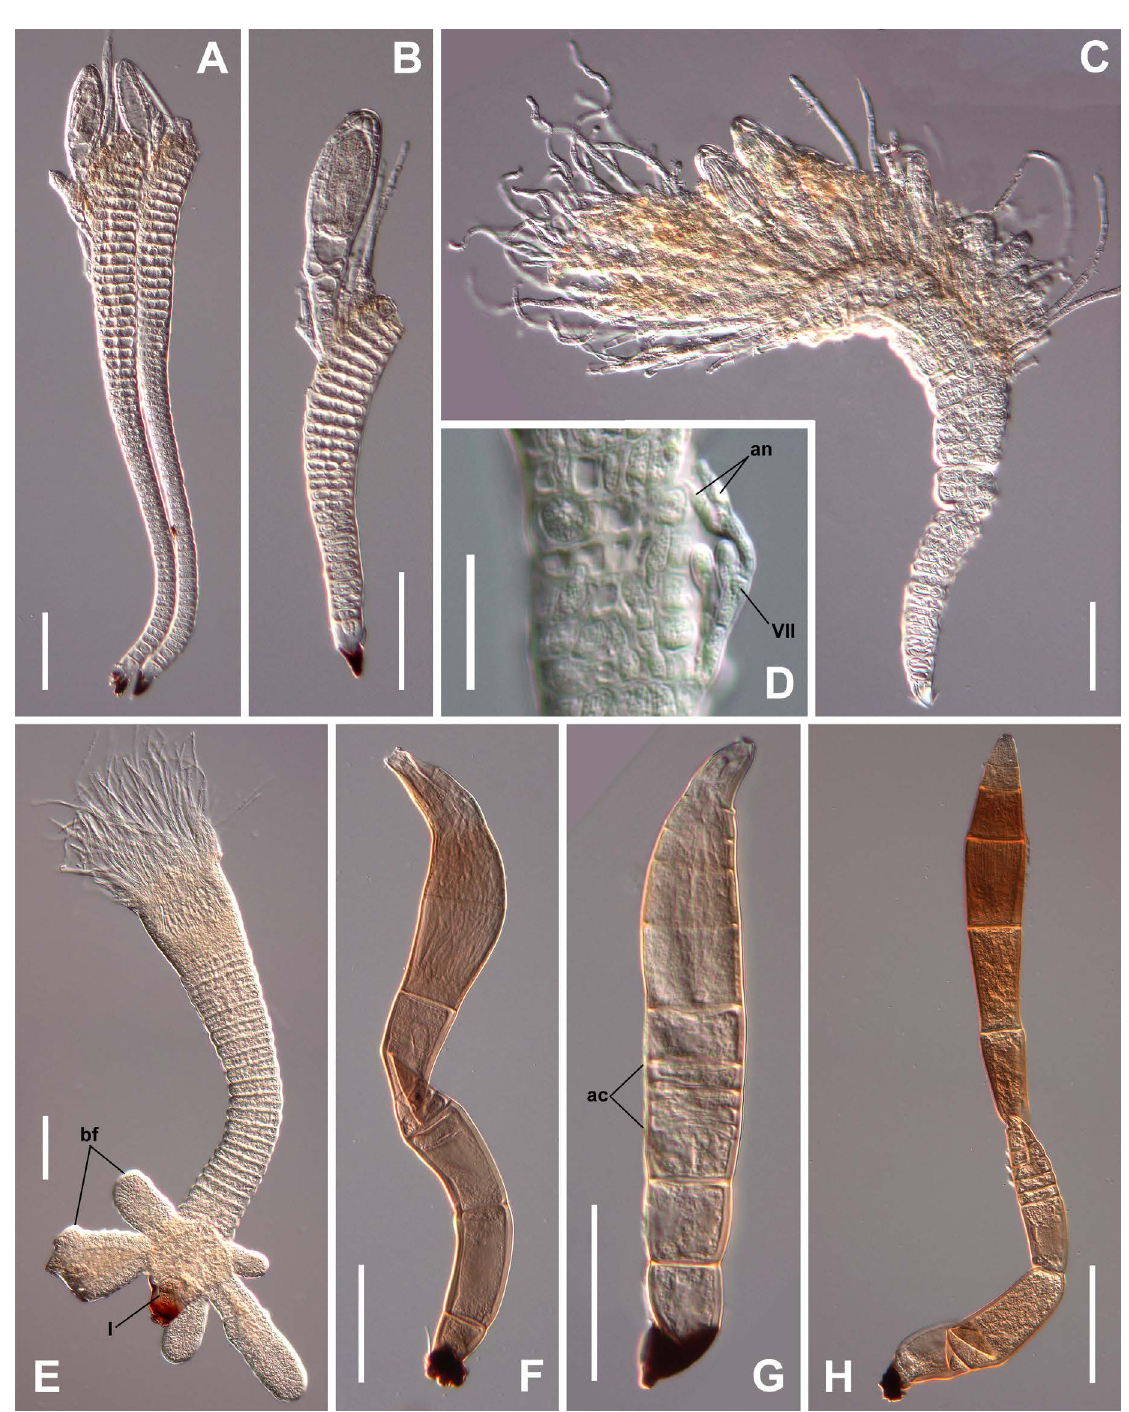
Fig. 4. A – D . Euzodiomyces lathrobii Thaxt. A – B . Reduced forms. C . Typical form. D . Labelling of a secondary axis, with antheridia (an) and perithecial initial with cell VII. – E . Zodiomyces vorticellarius Thaxt.; with labelled cell I and buffer projections (bf). – F . Coreomyces arcuatus Thaxt.; mature thallus. – G . Coreomyces corixae Thaxt.; mature thallus showing the appendiculate cells (ac). – H . Coreomyces macropus Thaxt.; mature thallus. Scale bars: A–C, E–H = 50 µm; D = 25 µm. Photographs from slides ZMUC C-F-123138 (A–B), ZMUC C-F-124066 (C), ZMUC C-F-122479 (D), ZMUC C-F-122570 (E), ZMUC C-F-124285 (F), ZMUC C-F-123723 (G), and ZMUC C-F-123722